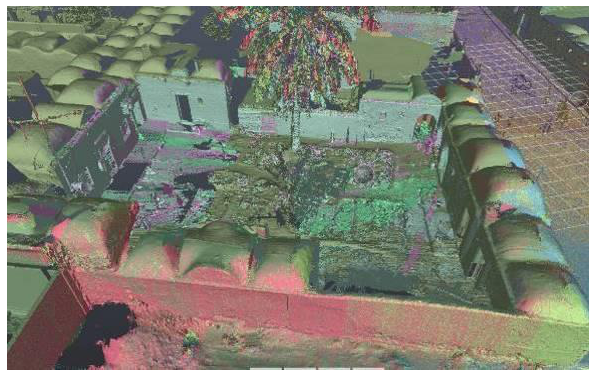
Figure 7. 3D survey of a typical minor building courtyard.